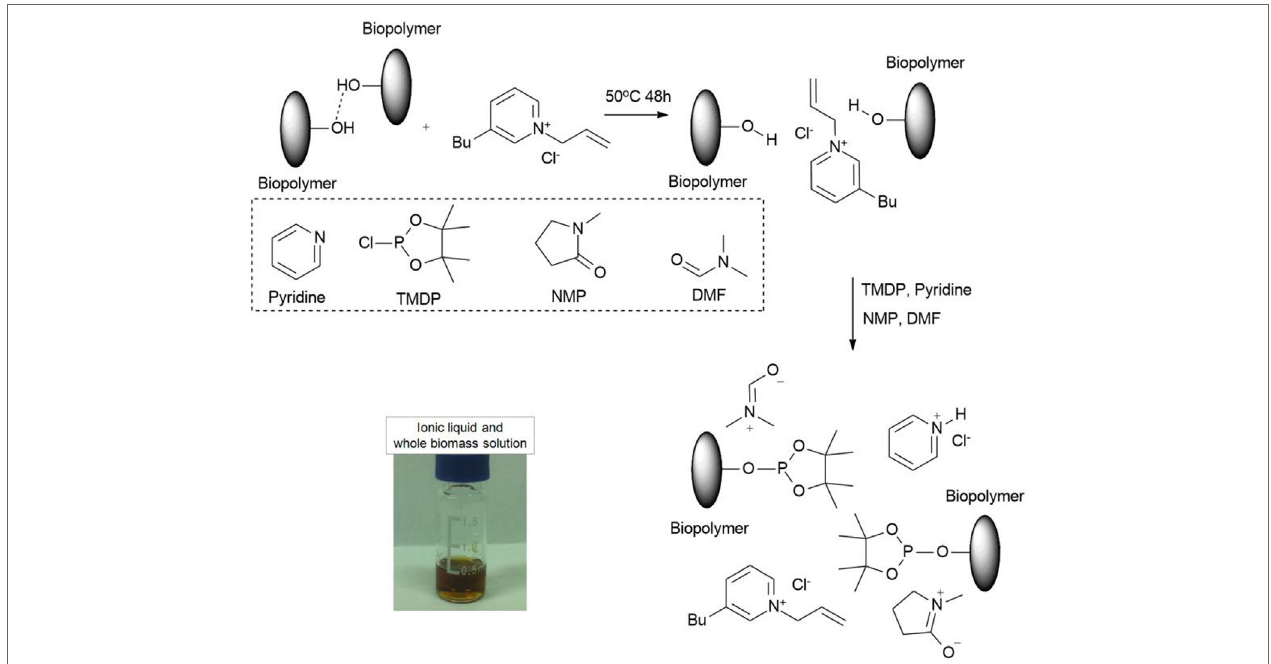
FigUre 2 | Possible dissolution and phosphitylation of biomass components and whole biomass in the ionic